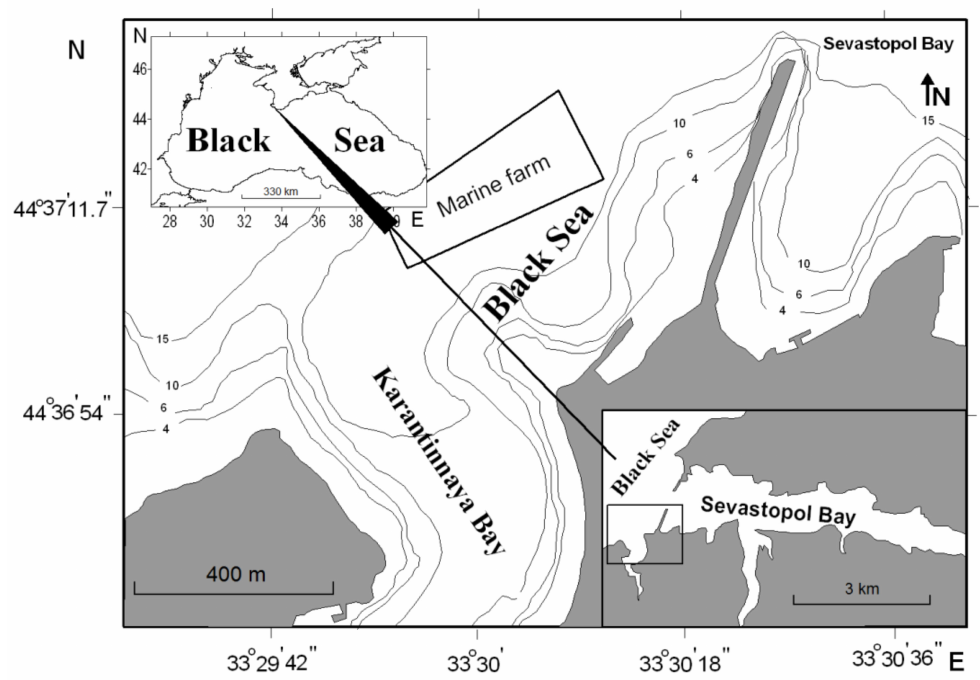
Figure 1. Mollusk sampling area in the Black Sea (marine farm). Lower right inset: position of the main panel (in rectangle). Upper left inset: sampling area location at the regional